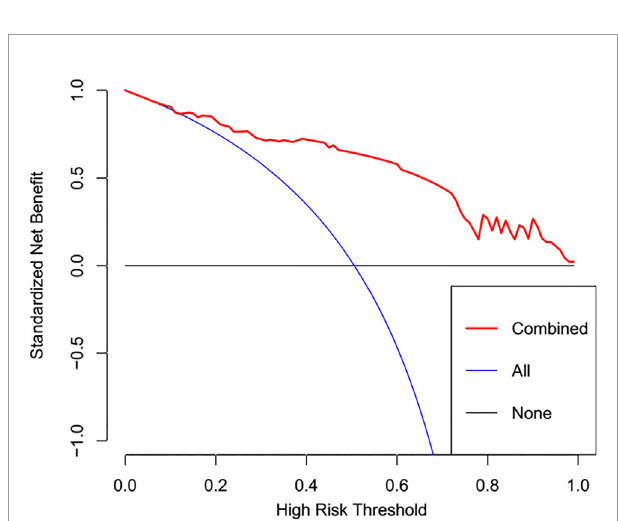
FIGURE 4 | ROC curves of the nomogram in the cN0 subgroup in the validation set.